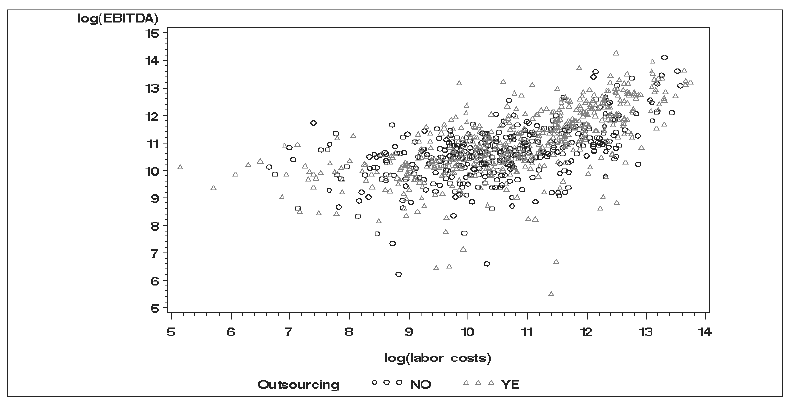
Figure 1b – Firms with employees by log(EBITDA) and log(labour costs) (grey triangle outsourcing firms; black circle non-outsourcing